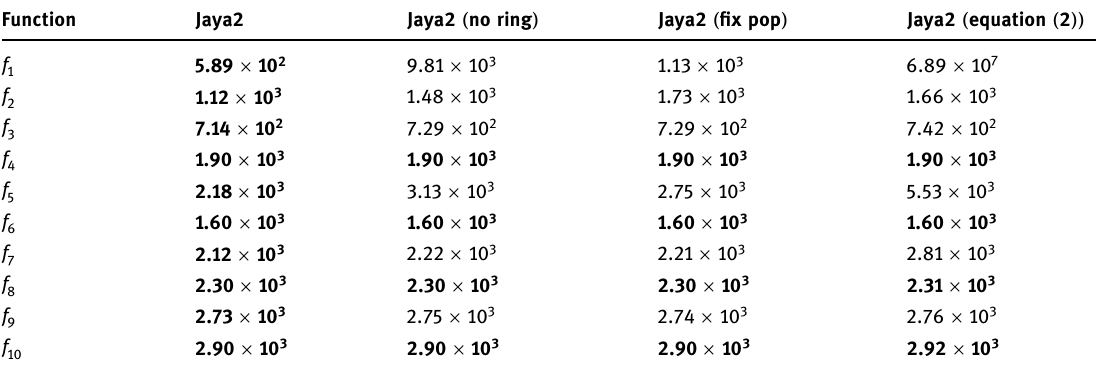
Table 18: The CEC 2020 ( = D 10 ) median function values achieved by Jaya2, Jaya2 ( no ring ) , Jaya2 ( fi x pop ) , and Jaya2 ( equation ( 2 )) over 30 runs and 100,000 function evaluations Function